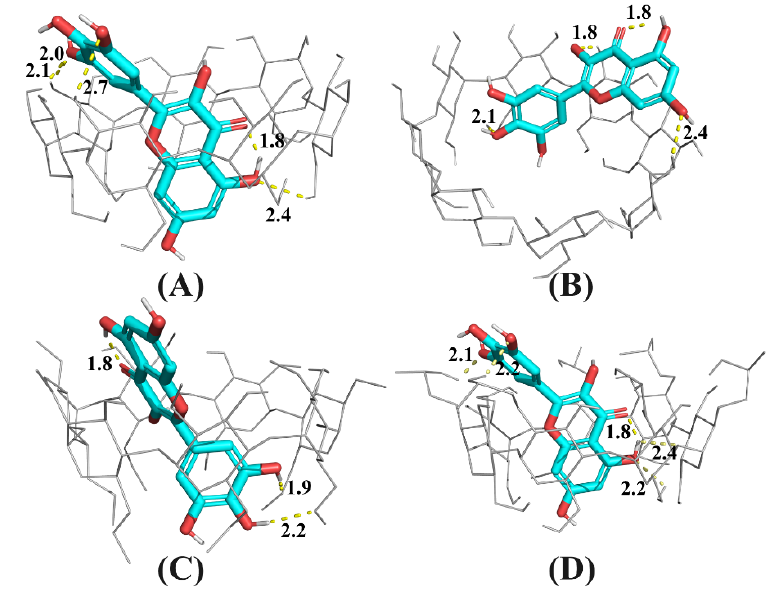
Figure 6. Snapshot of the lowest energy docking result for CD: myricetin complexes, where CD is β-CD ( A ), γ-CD ( B ) DM-β-CD ( C ), or HP-β-CD ( D ). Hydrogen bonds are dashed lines with indicated distances (in Å).